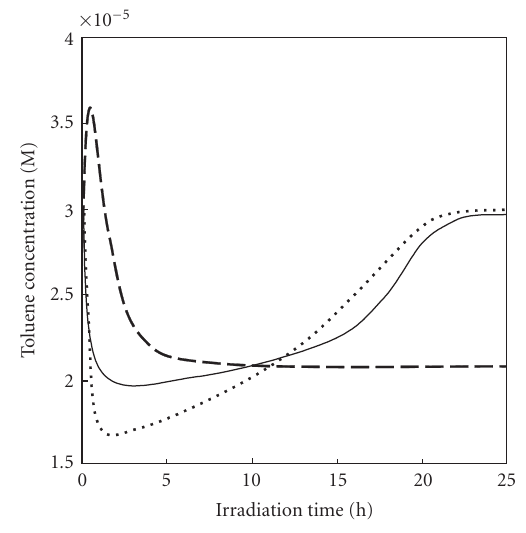
Figure 3: Toluene photocatalytic degradation in gas-solid regime. Experimental results of outlet toluene concentration versus irradia- tion time by using TiO 2 Degussa P25 in the presence of water [ ··· ] and TiO 2 Merck in the presence (- - -) or in the absence (—) of water vapour. Flow rate: 0 . 04cm 3 · s − 1 ; inlet toluene concentration: 0 . 03mM, water vapour concentration: 0 .